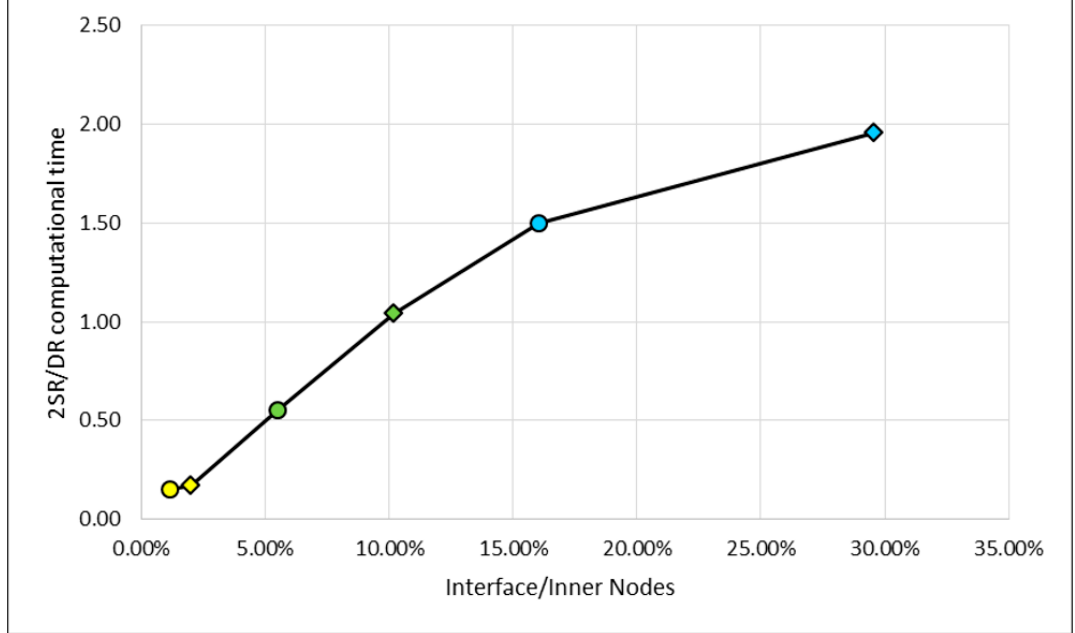
Figure 9. Graph 2S/D calculation time vs. Interface/Inner nodes number.